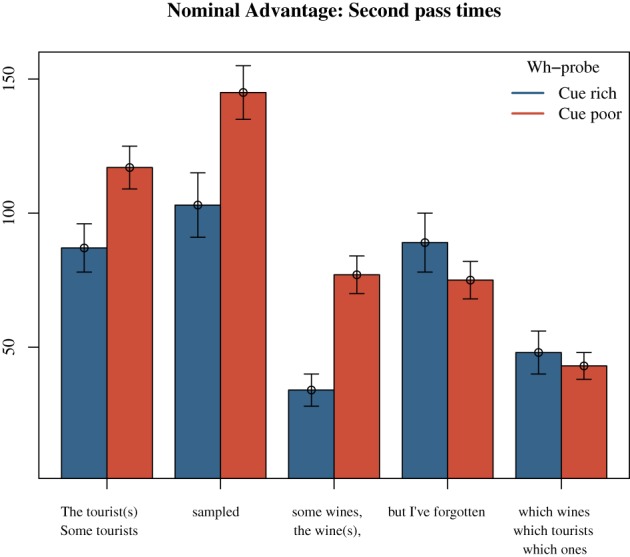
Experiment 2: effect of Locality on the remnant region. Nominal advantage in second pass re-reading times. Times presented in ms.